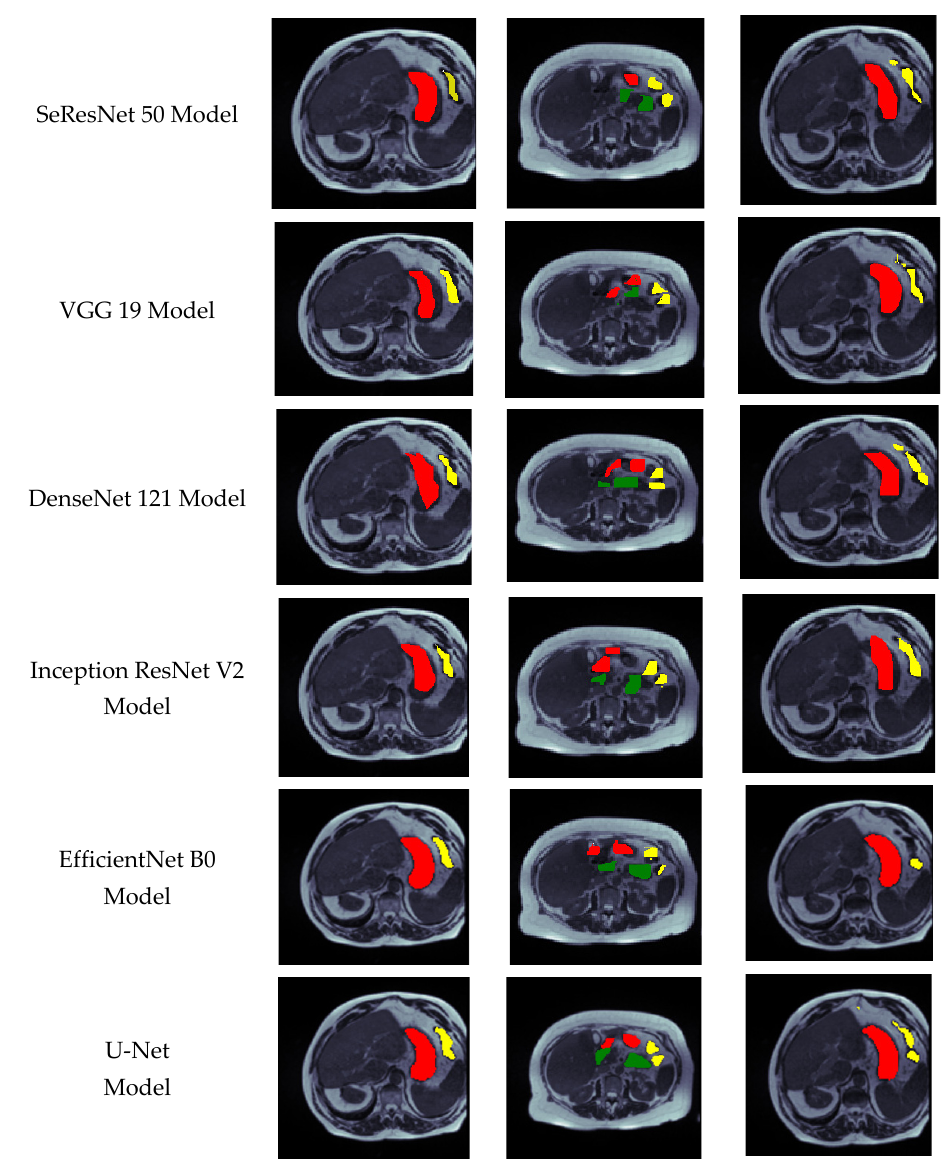
Figure 14. Visual analysis of the results.